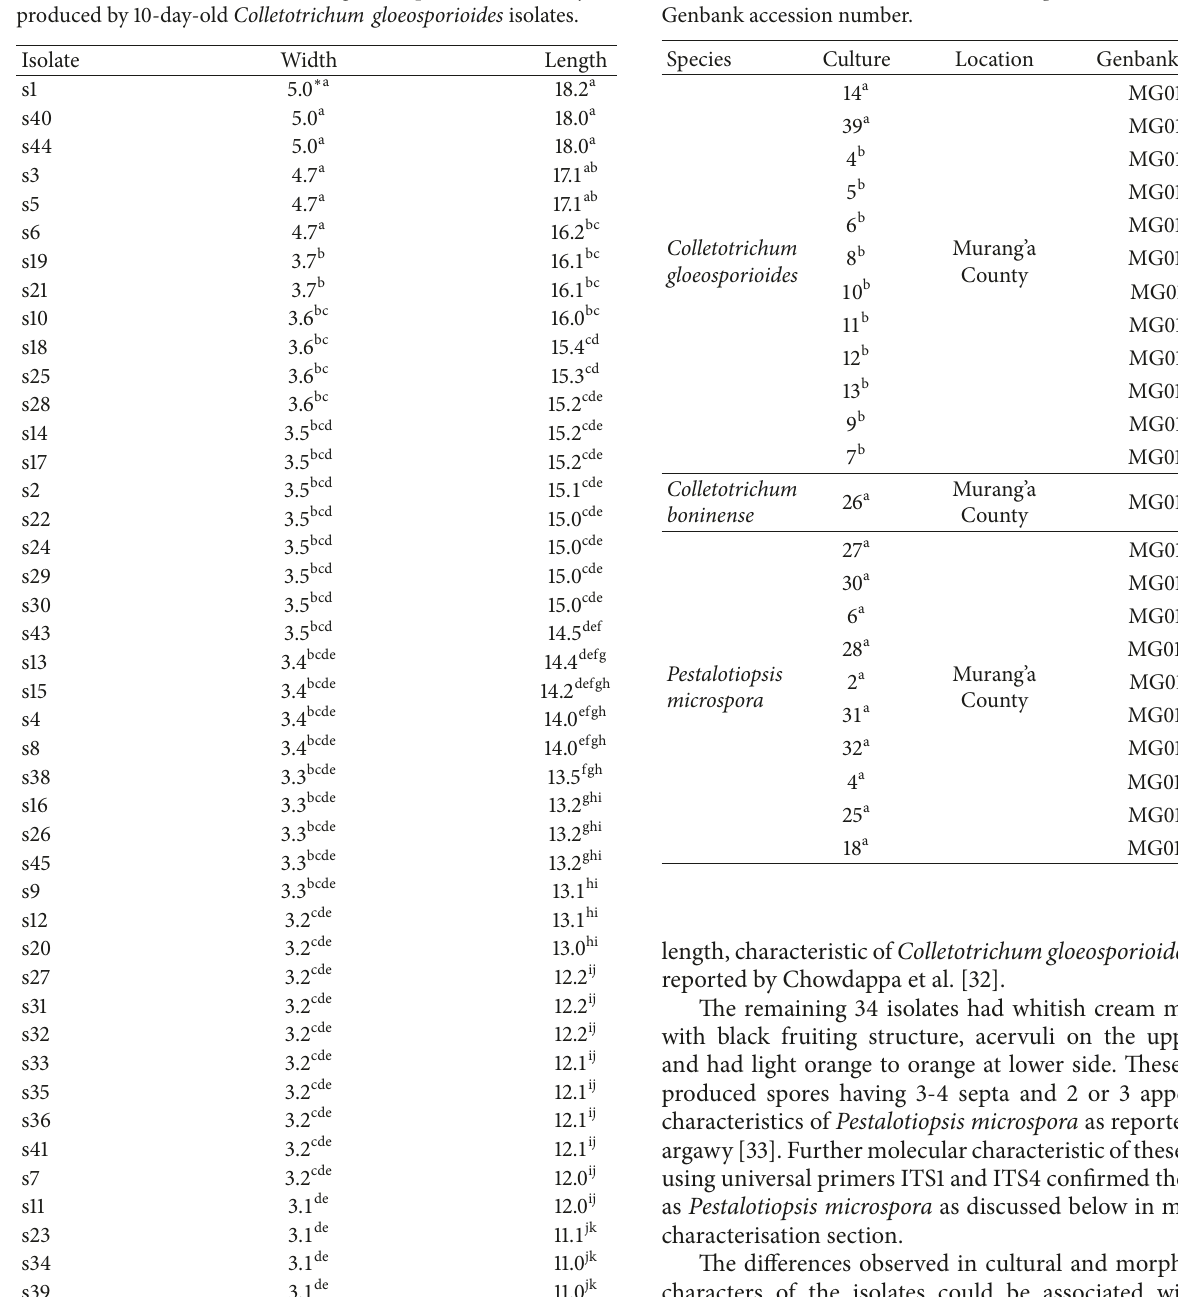
Table 3: The mean width and length of spores in micron( 𝜇 m) produced by 10-day-old Colletotrichum gloeosporioides isolates.